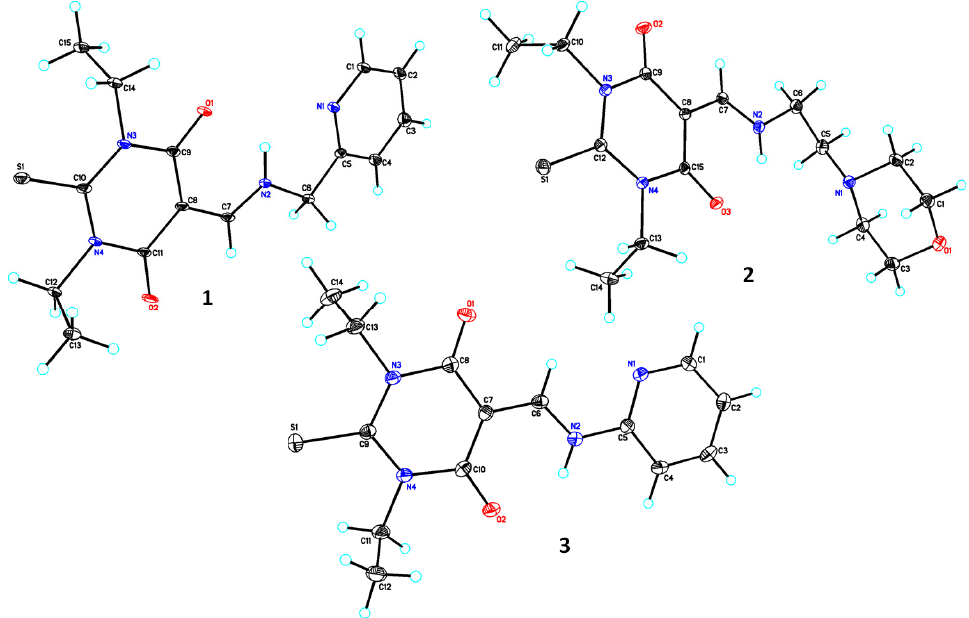
Figure 2. The ORTEP view of compounds 1 – 3 drawn at 30% probability level.